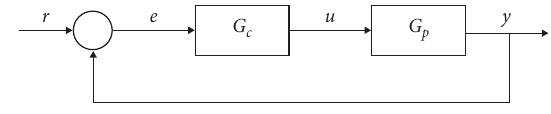
Figure 1: Classical control system framework.